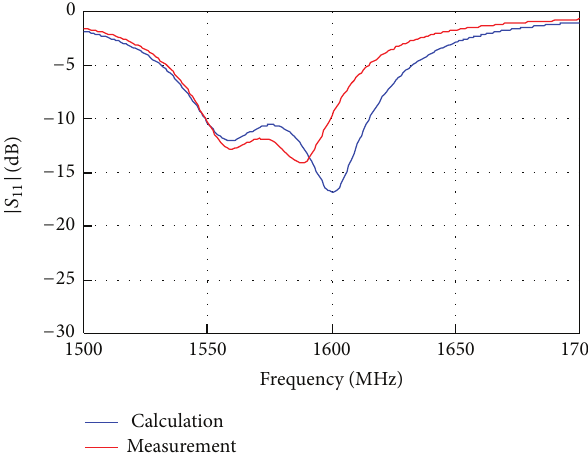
Figure 13: Input characteristics of CP patch